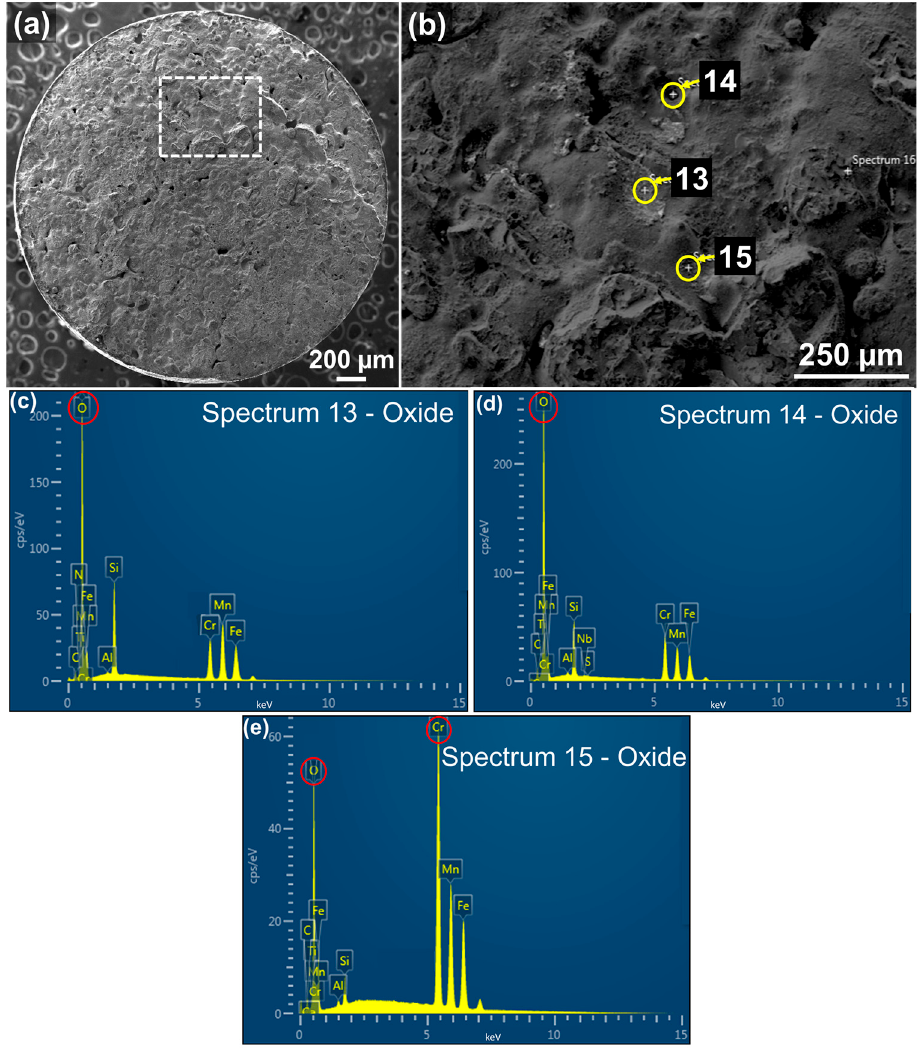
Figure 9. SEM micrographs showing oxide inclusions ( a ) overall fracture surface; ( b ) high magnification of a selected area from ( a ) marked by a dashed box showing oxide inclusions; and ( c – e ) EDS spot spectra detected on the corresponding spots marked by circles in ( b ). Table 4. Elemental composition distribution of the oxide particles from EDS analyses on the corresponding spots marked in Figures 8b and 9b (wt %).